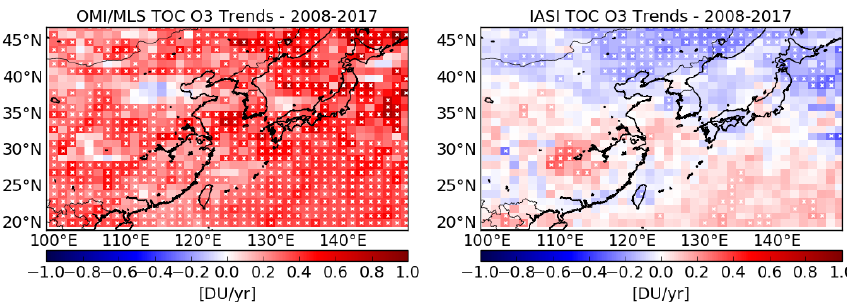
Figure 7. O 3 trends derived for the tropospheric O 3 column (TOC) from OMI/MLS and IASI for 2008–2017 at 1 ◦ × 1 ◦ resolution. The TOC is calculated using the same tropopause height for OMI/MLS and IASI. White crosses indicate associated p values smaller than